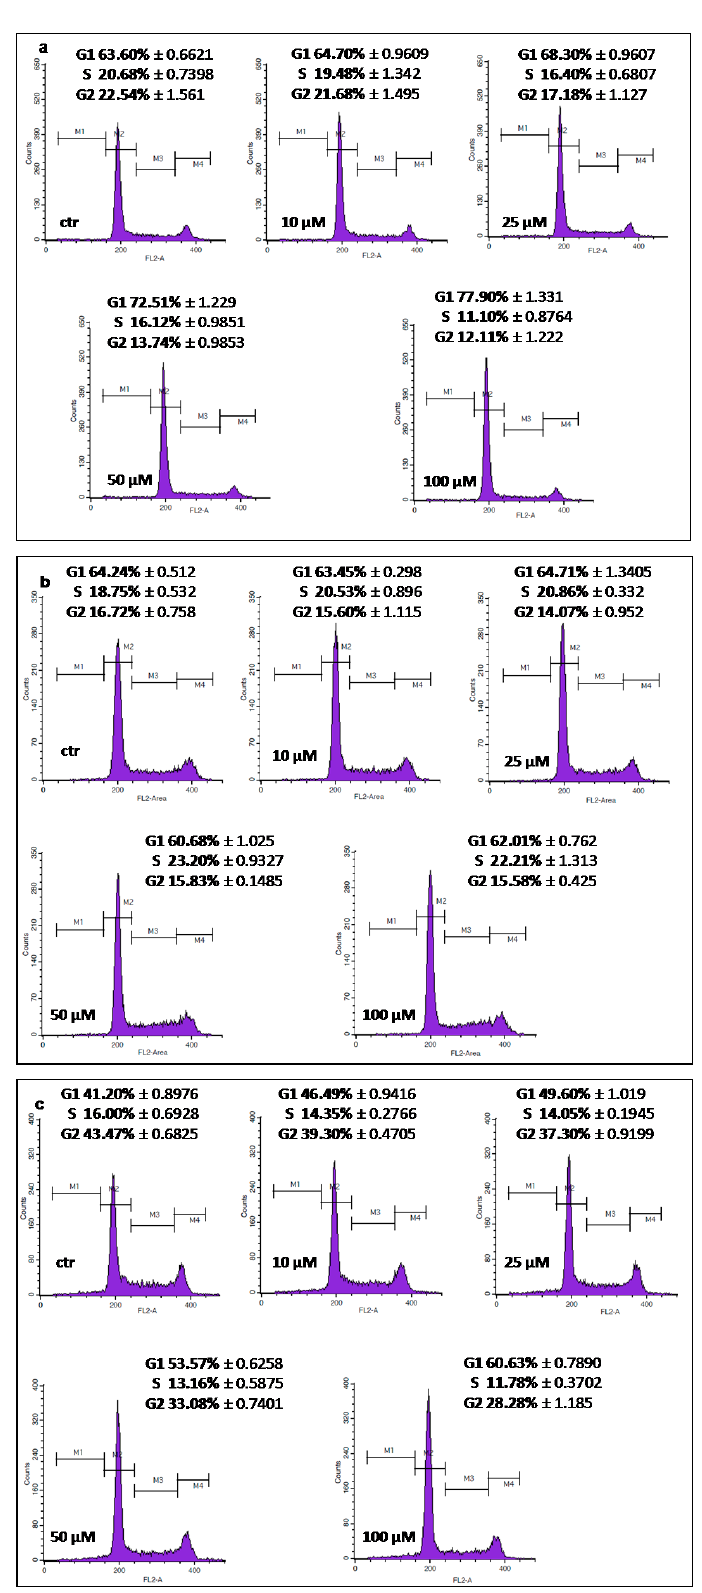
Figure 5. Representative histogram plots of the flow cytometry analysis (DNA content) of RK33 ( a ), RK45 ( b ), and TE671 ( c ) cells upon imperatorin treatment. Results are presented as mean ± SEM, n=9 per concentration from three independent experiments (* p < 0.05; ** p < 0.01; *** p < 0.001; **** p < 0.0001 versus control; Tukey’s test).